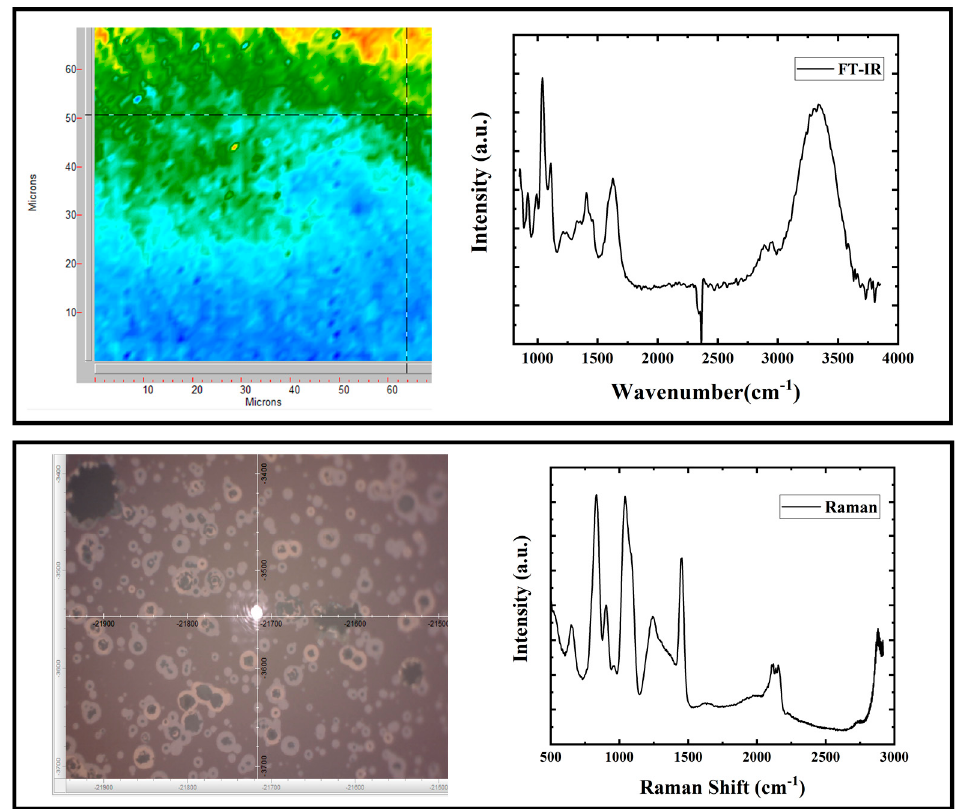
Figure 1. Examples of obtained spectra from Raman and FT-IR microscope imaging systems and the images of measurement locations.